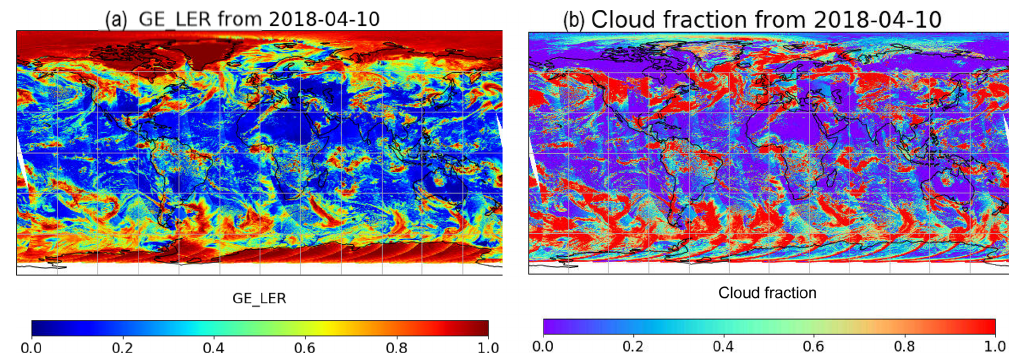
Figure 6. (a) GE_LER in the total ozone fitting window (325–335nm) retrieved from TROPOMI/S5P data on 10 April 2018 and (b) the corresponding cloud fraction for this day.